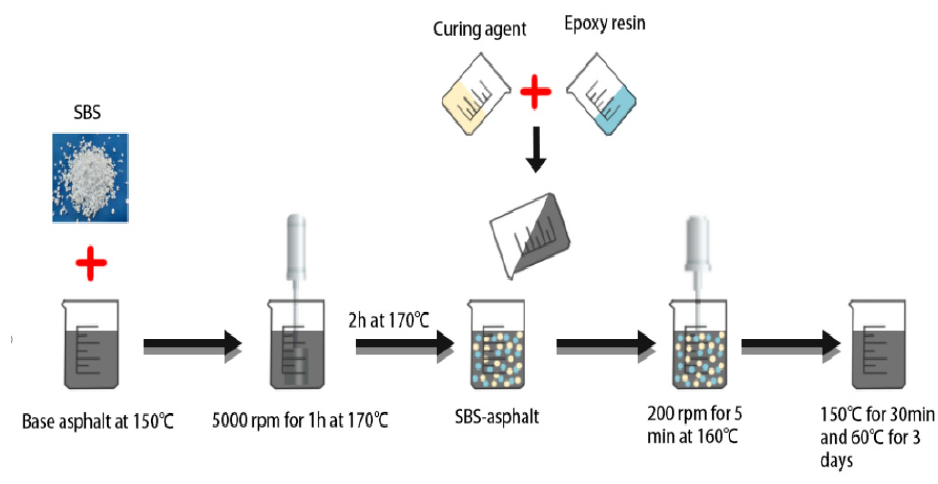
Figure 1. Flow chart of the preparation of ER/SBS composite modified asphalt.